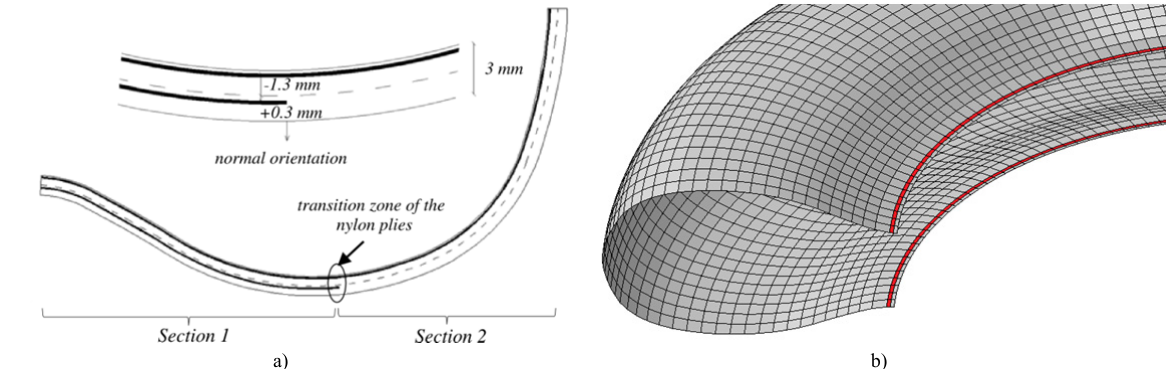
Fig. 5 Definition of rebar layers in the efficient shell model of the bias-ply tyre: a) Nylon cord plies and b) Steel bead